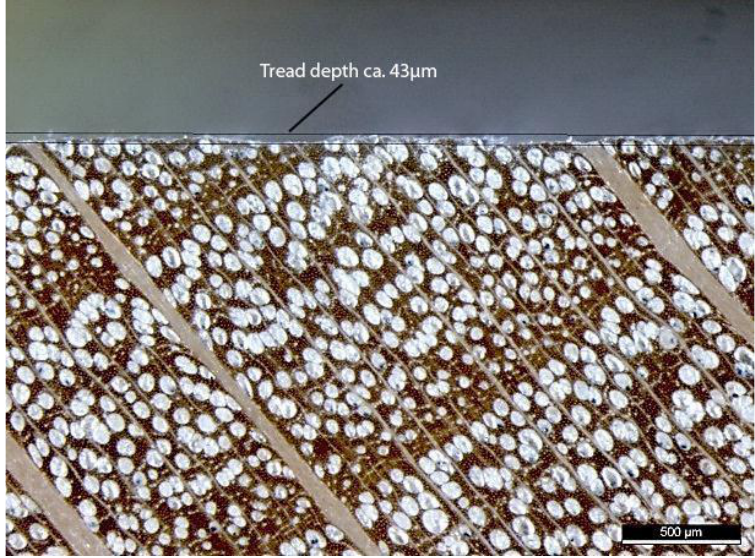
Figure 1. Micro-structured surface of beech with a profile depth of 43 µm, reprinted with permission from ref. [31]. 2013© Föhn and Mathis